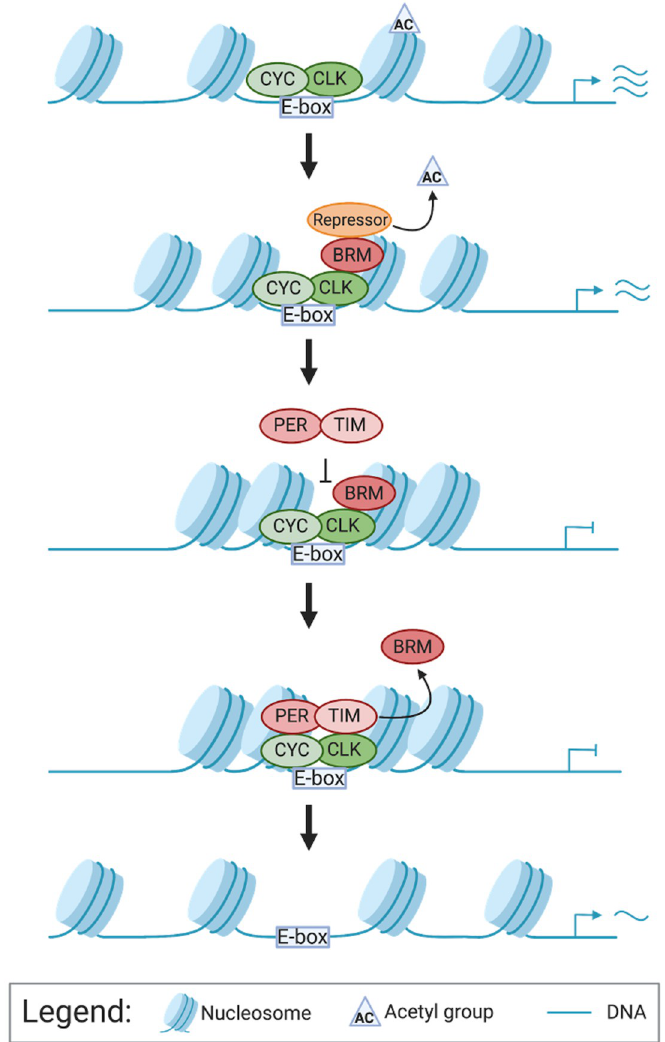
Fig 5. Model depicting the impact of CLK and TIM on BRM occupancy at the per promoter. CLK-CYC heterodimers bind to the E-box of per to activate transcription. At the peak of transcription, CLK promotes BRM binding to the chromatin. While bound, BRM condenses the chromatin and recruits repressors to reduce gene transcription levels. When PER-TIM complexes are in the nucleus to repress CLK-CYC activated transcription, TIM promotes the removal of BRM from the DNA to reset the chromatin for the next cycle of transcription. This figure was created with BioRender.com (license to lab of JCC).